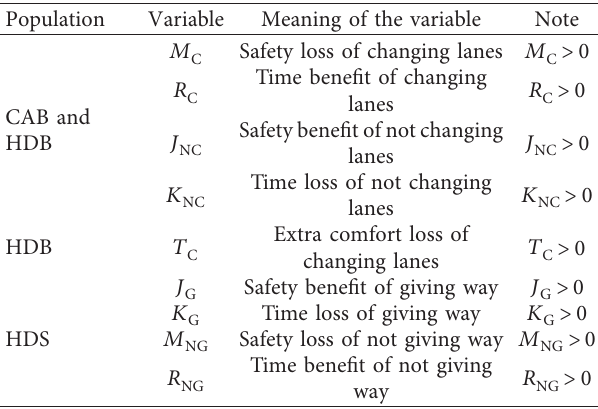
Figure 1: Scenarios of lane changing game in (a) Model 1 and (b) Model 2. Table 1: Variables and their meanings.